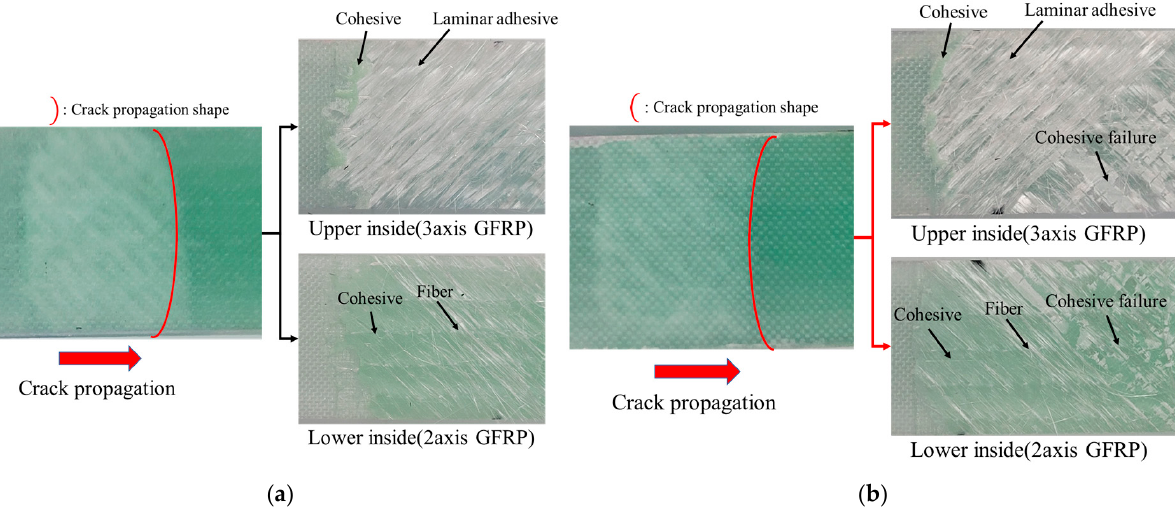
Figure 11. Fracture cross-section of Mixed-mode test results: ( a ) c = 82.9 mm, mode mixture ratio = 0.23; and ( b ) c = 31.2 mm, mode mixture ratio = 0.64.